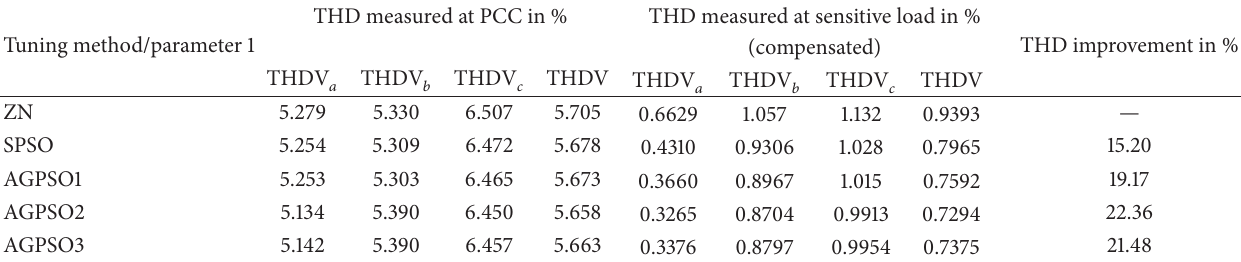
Table 1: Harmonic mitigation of three-phase balanced fault.